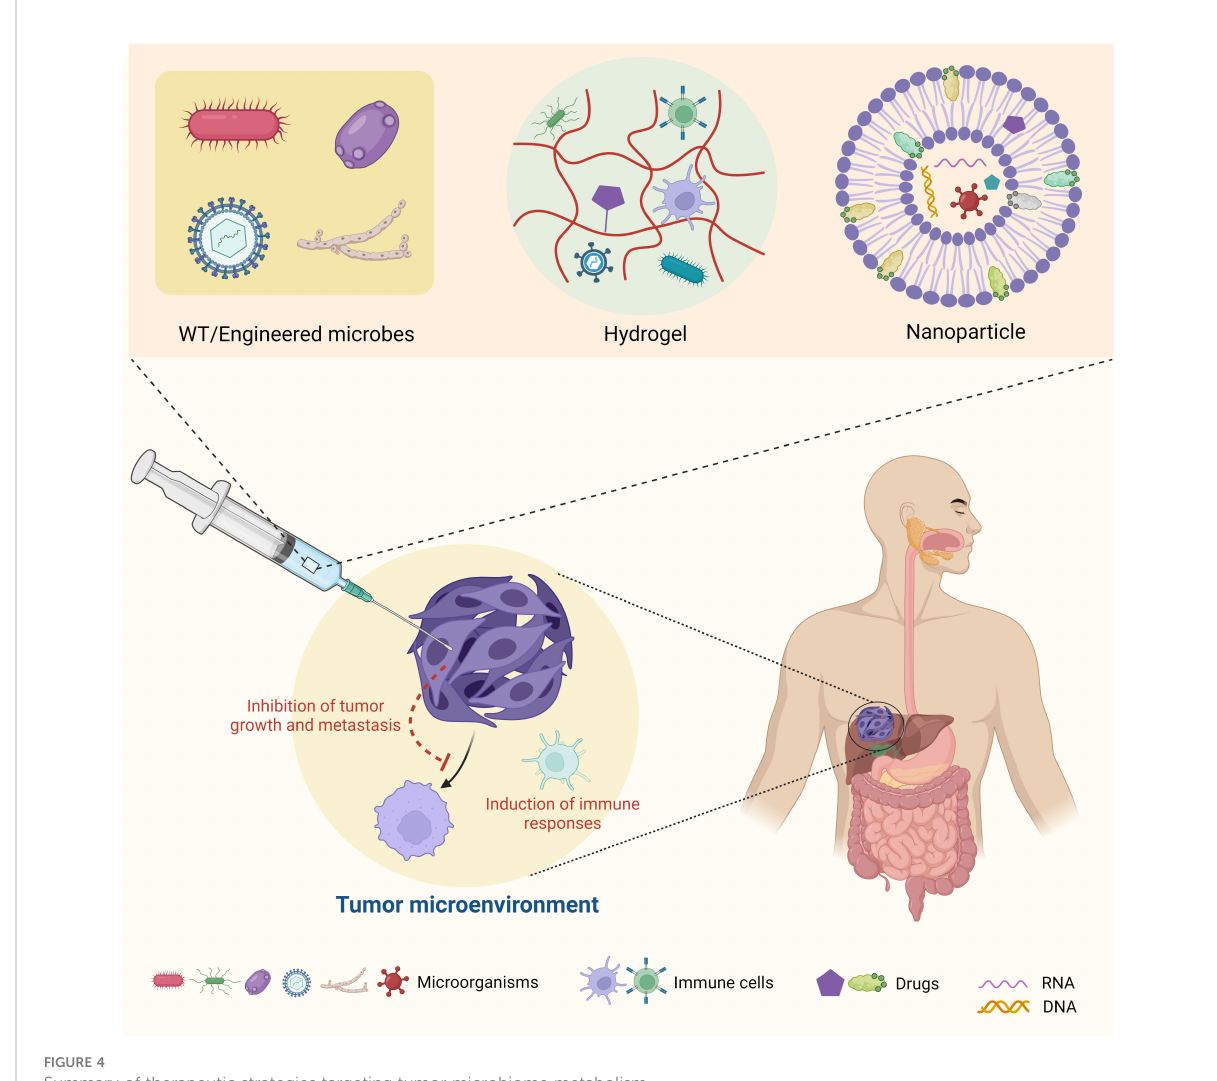
FIGURE 4 Summary of therapeutic strategies targeting tumor microbiome